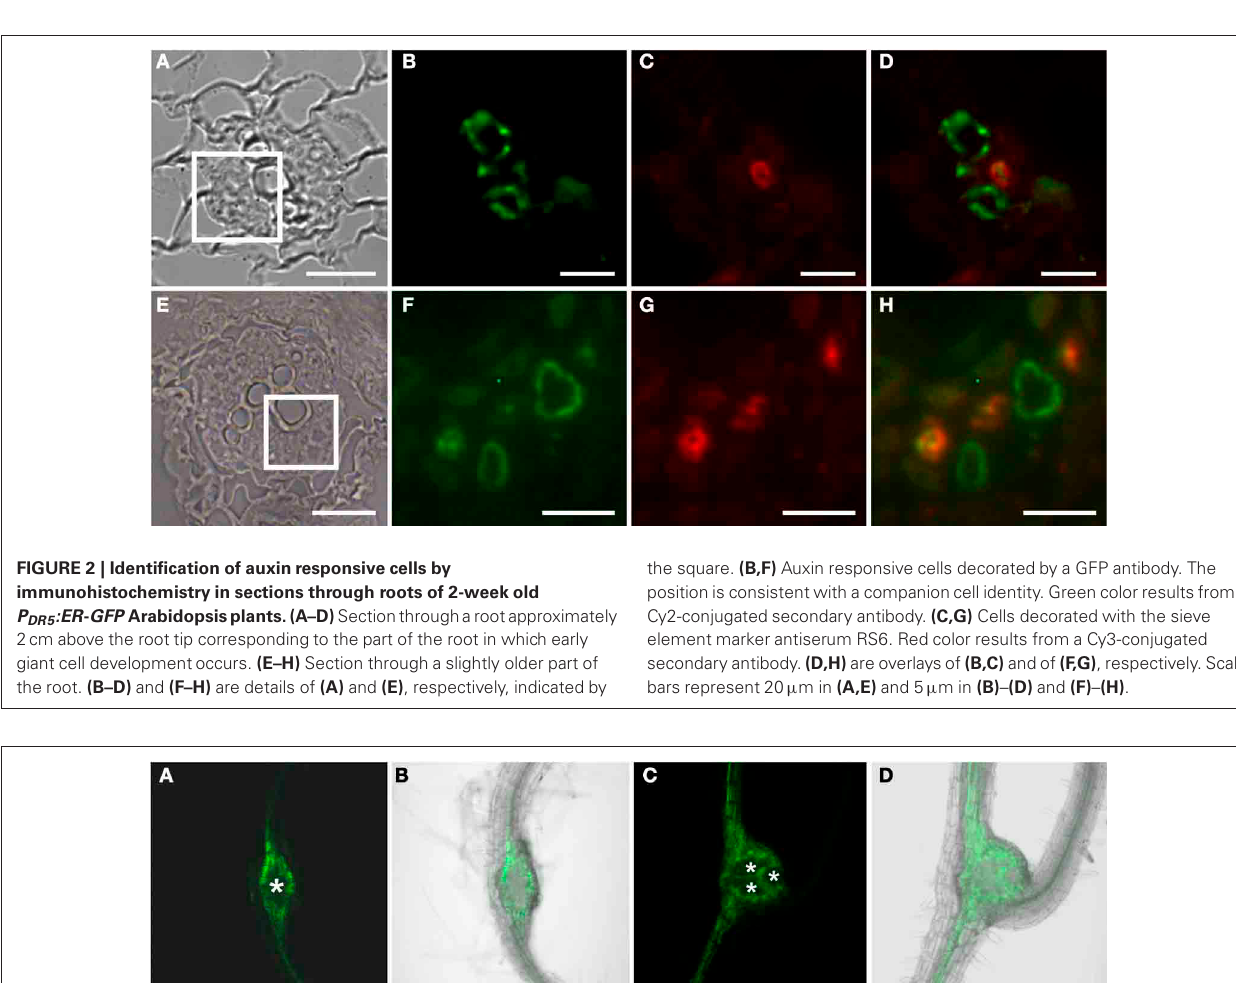
GFP fluorescence. (A , C,E,G) GFP fluorescence. (B , D , F,H) Overlay of GFP fluorescence and bright field image. (A,B) 7dai, (C,D) 14dai (E,F) 17dai, (G,H) 21dai. Scale bars represent 100 µ